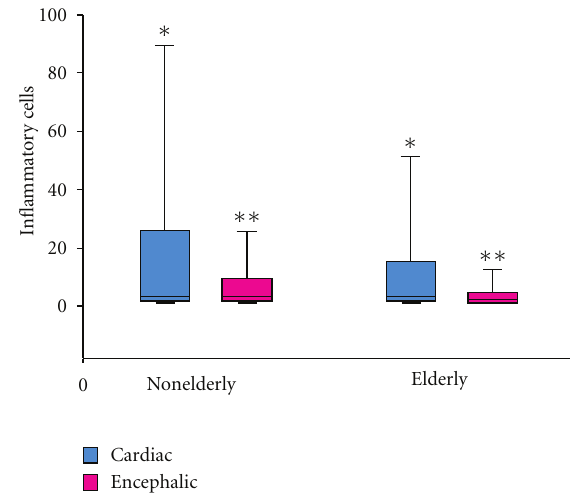
Figure 1: Comparison of the inflammatory infiltrate in heart and brain of non-elderly and elderly patients with